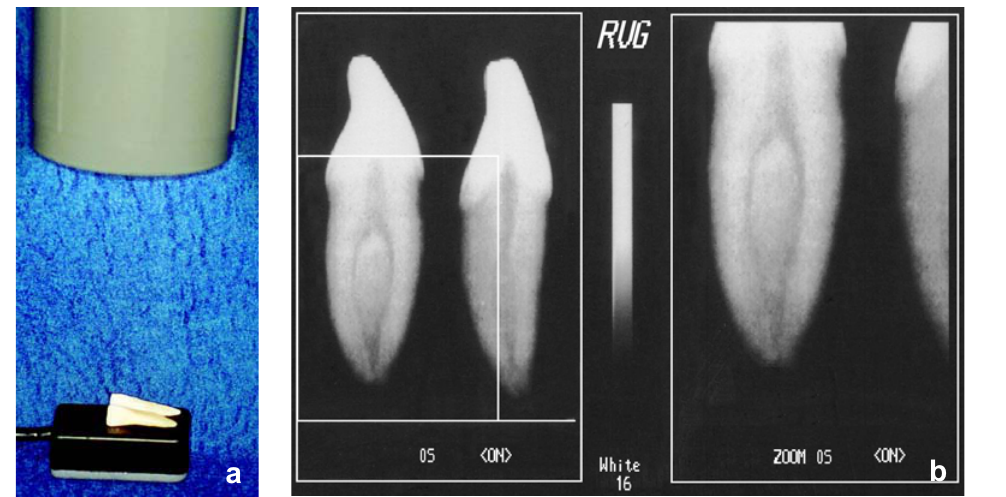
a b FIGURE 3- Examination (a) and images (b) in vitro in the MD direction with RVG